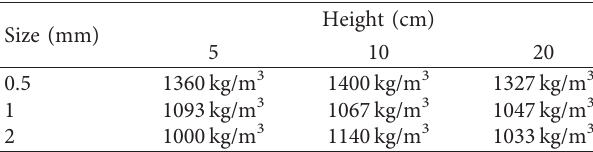
Figure 5: Comparison of XRD diffraction experiments at different temperatures. Table 1: Experimental material